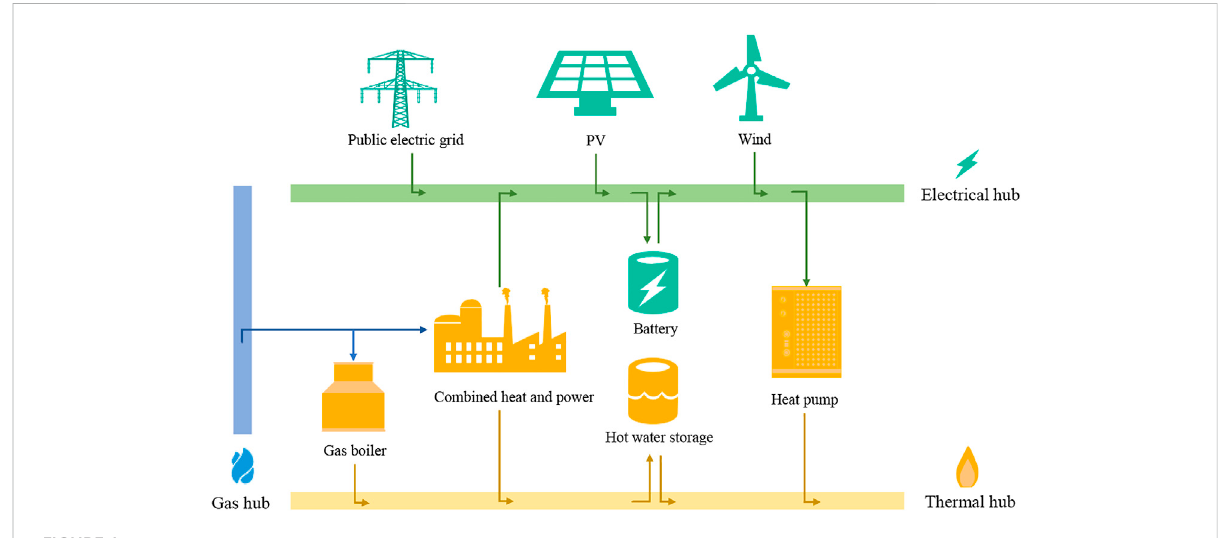
FIGURE 1 Hybrid CHP system integrated with renewable